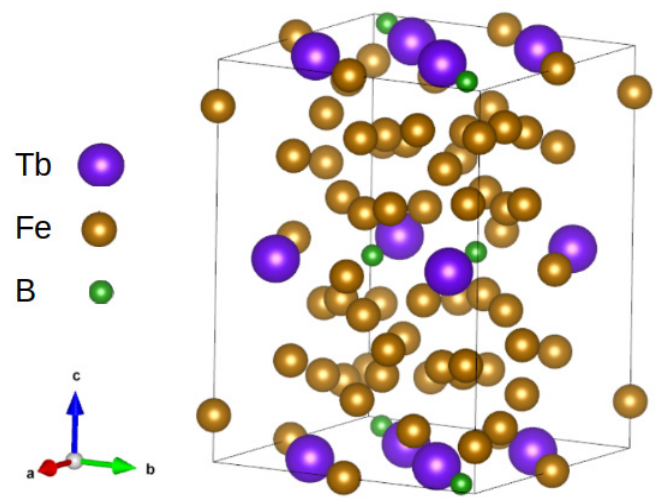
Figure 1. Crystal structure of Tb 2 Fe 14 B.